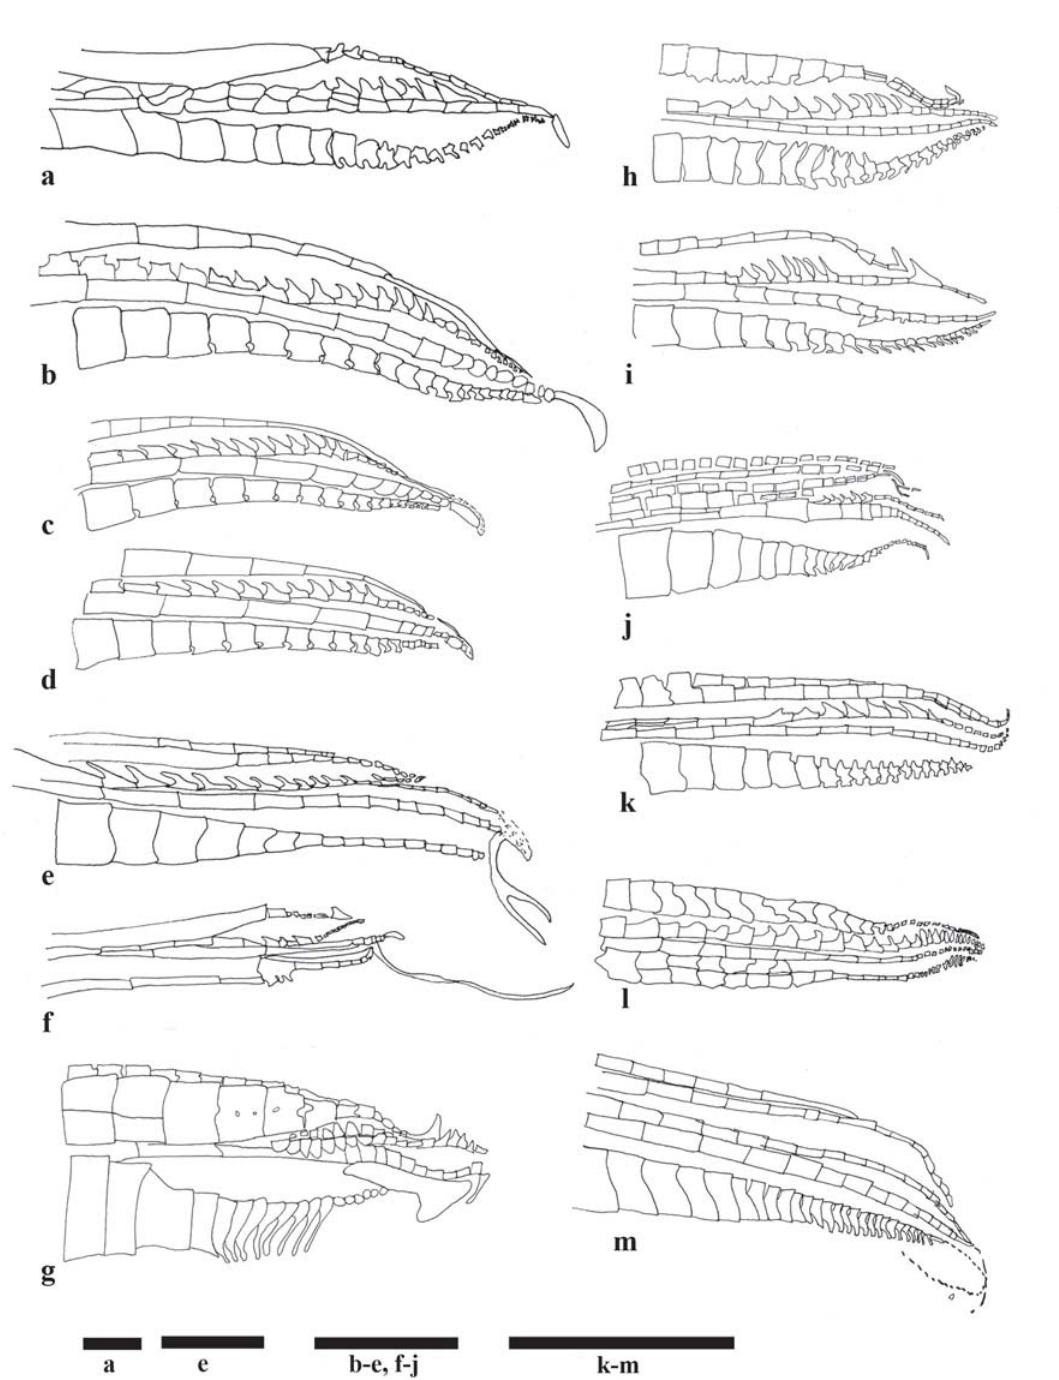
Fig. 8. Lateral view of the tip of gonopodium in: a ) Heterandria formosa , TU 24002; b ) Pseudoxiphophorus cataractae , LSUMZ 14338; c ) Pseudoxiphophorus obliquus , LSUMZ 14339; d ) Pseudoxiphophorus litoperas , USAC 1813; e ) Phalloceros caudimaculatus , MCP 40527; f ) Cnesterodon decemmaculatus , MCP 35215; g ) Xiphophorus mayae , LSUMZ 14336; h ) Poecilia rositae , USAC 1822; i ) Gambusia affinis , TU 114758; j ) Phallichthys fairweatheri , USAC 1797; k ) Brachyrhaphis rhabdophora , TU 84483; l ) Pamphorichthys araguaiensis , MCP 40919; m ) Alfaro cultratus , TU 24927 . Scale bars = 1